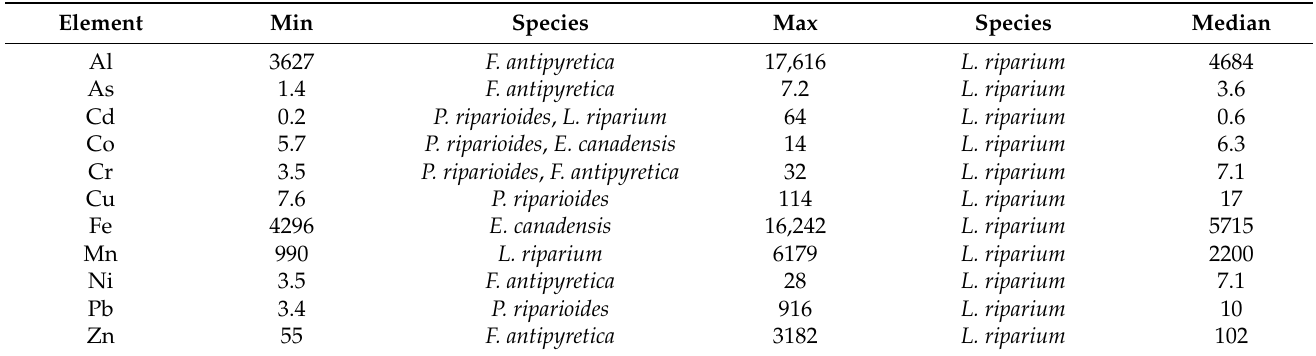
Concentrations (minimum, maximum, and medians) of the analyzed elements in biomonitors, mg kg − 1